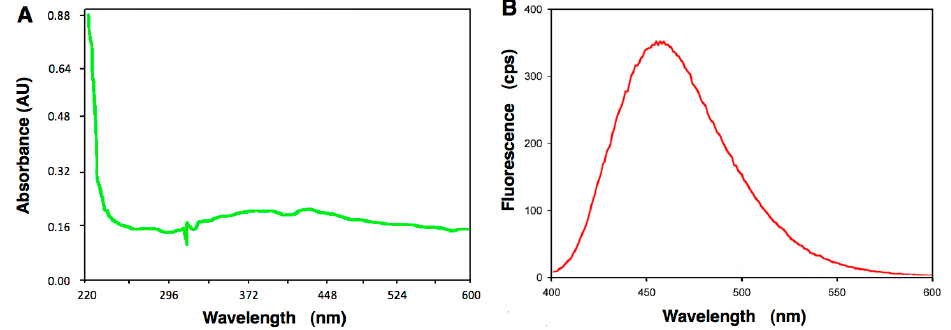
Figure 4. Fluorescent properties of A6. ( A ) Absorption spectrum; ( B ) Fluorescence spectrum after excitation at λ = 372 nm.